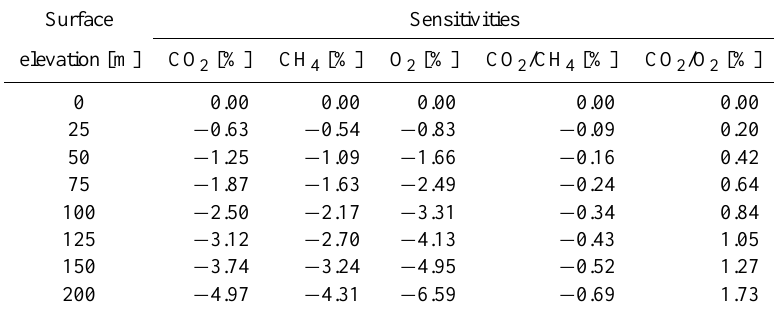
Table 4. Surface elevation sensitivity of total column concentrations and their ratios for an aircraft altitude of 1.25km and a solar zenith angle (SZA) of 40 ◦ .